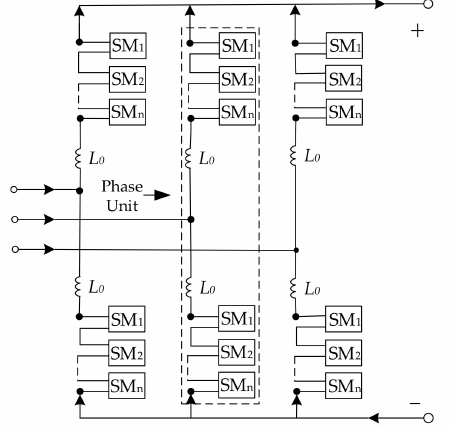
Figure 2. Topological structure of an MMC.